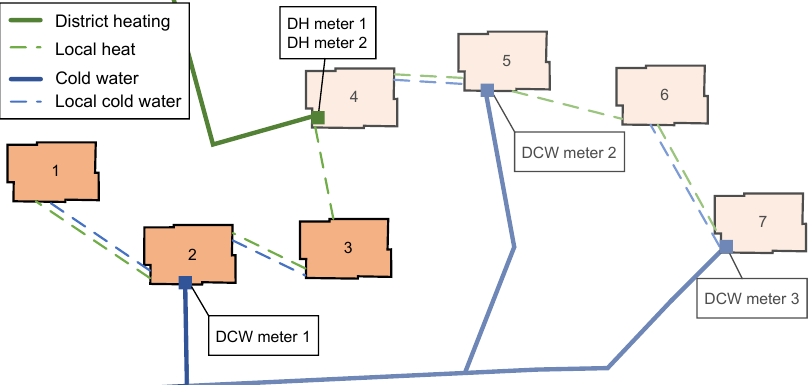
Figure 6. One year of domestic hot water (DHW) usage probability density distributions, grouped per hour and weekday: N denotes the number of apartments over which the measurements are averaged.